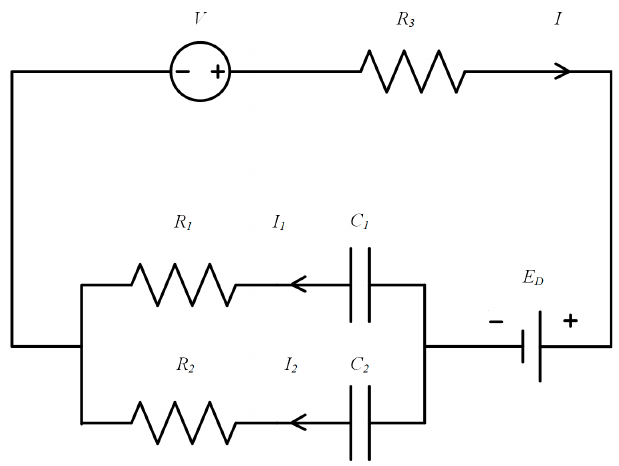
Figure 8. The equivalent circuit of the electrodeposition system for hydrogel. V is the applied voltage. E D is counter potential, includes solution’s hydrolysis potential and contact potential drop. C 1 represents the capacitor between two plate electrodes. C 2 represents the double layer capacitor between ITO surface and solution. Resistor R 1 is the equivalent series resistance of C 1 . Resistor R 2 includes the equivalent series resistance of C 2 and solution’s resistance. Resistor R 3 includes power supply’s internal resistance and wires’ resistance.